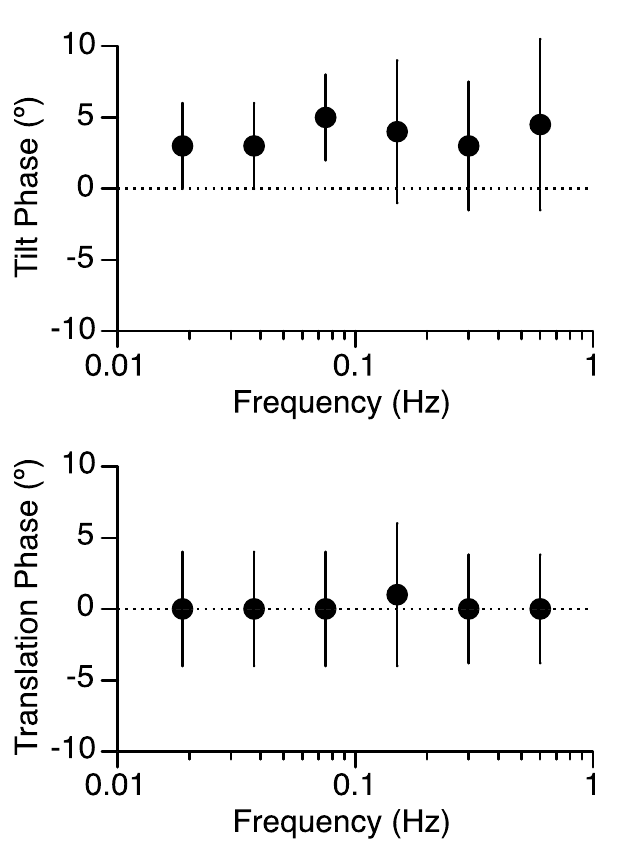
Figure 5. Mean ± standard error of the phase of the joystick tilts and translation displacements as a function of motion frequency during off-vertical axis rotation (OVAR) in 12